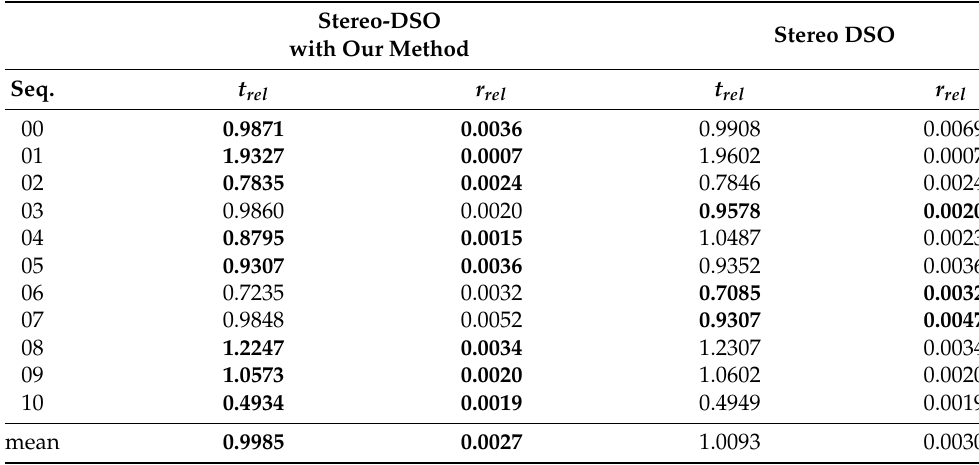
Table 1. Results of Stereo DSO with and without the proposed method on the KITTI dataset. t rel